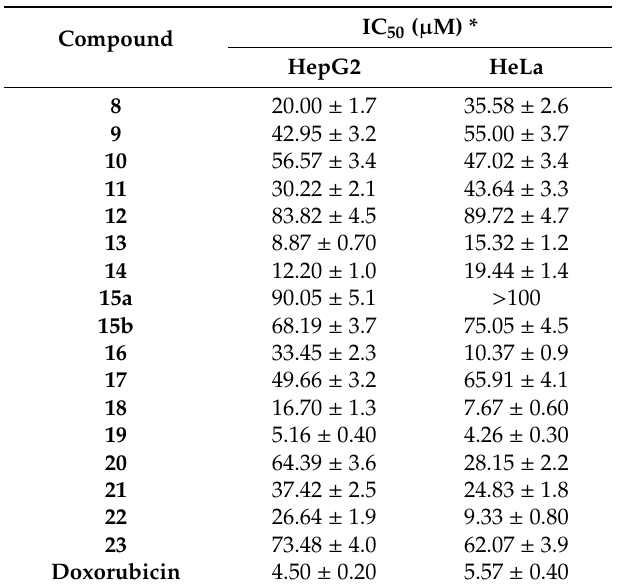
Table 1. IC 50 values obtained for the tested compounds against both HepG2 and HeLa cell